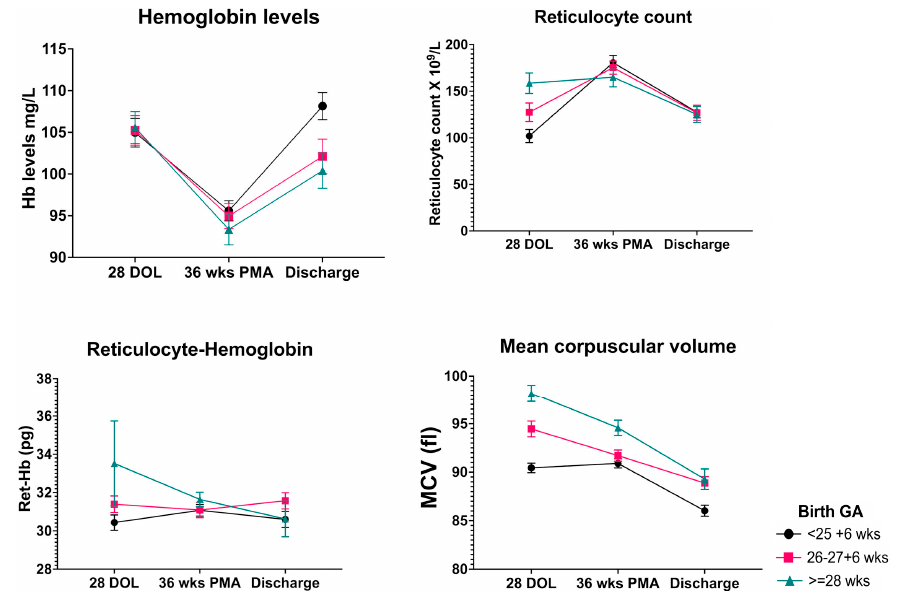
Figure 1. Longitudinal changes in hematological parameters during NICU admission in extreme preterm neonates. Mean and SEM of each hematologic variable specific to each age group is plotted to depict the natural history of changes over time. There is a tendency towards decreasing Hb levels and corresponding increase in reticulocyte counts between 28 days of life and 36 weeks PMA. On the contrary Ret-Hb levels remain unchanged during the NICU course, but MCV levels fall significantly with increasing postnatal age. Abbreviations: GA, Gestational Age; DOL, Days of Life; PMA, Postmenstrual Age; Hb, Hemoglobin; Ret-Hb, Reticulocyte Hemoglobin; MCV, Mean Corpuscular Volume.